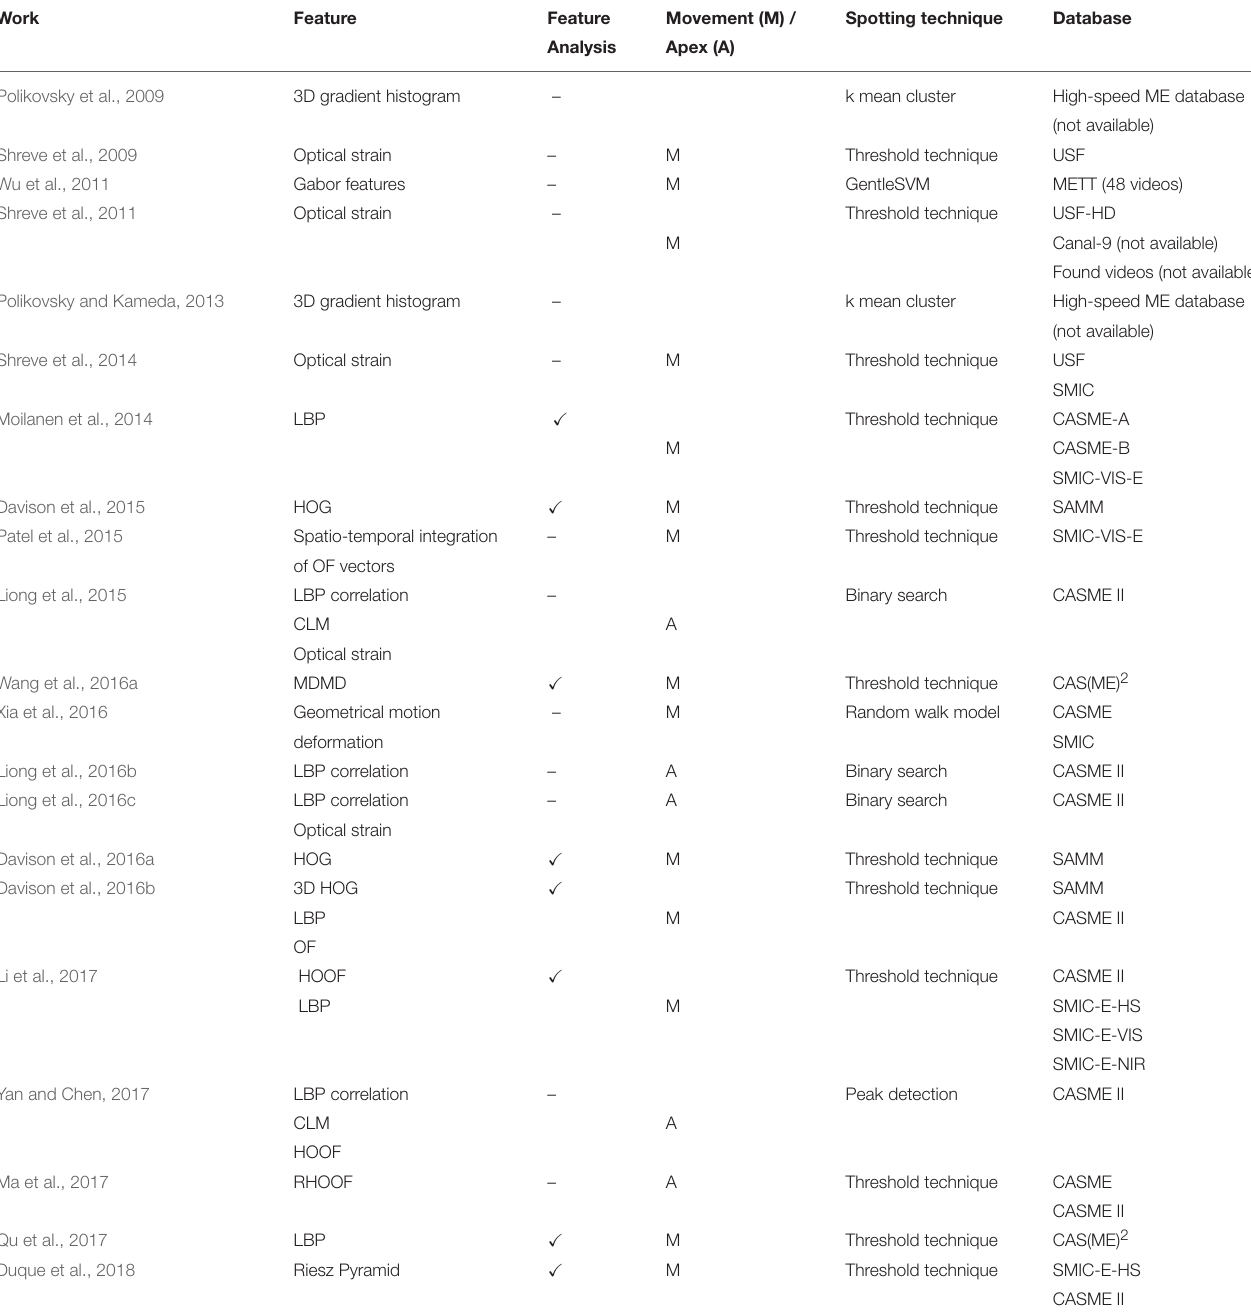
TABLE 3 | Facial micro-expression (or micro-movement) spotting works in